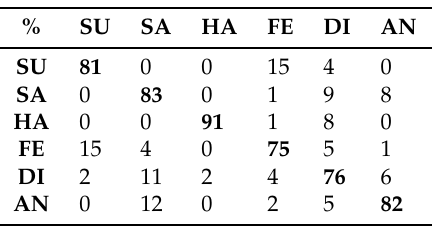
Table 9. Confusion matrix: 39 features.